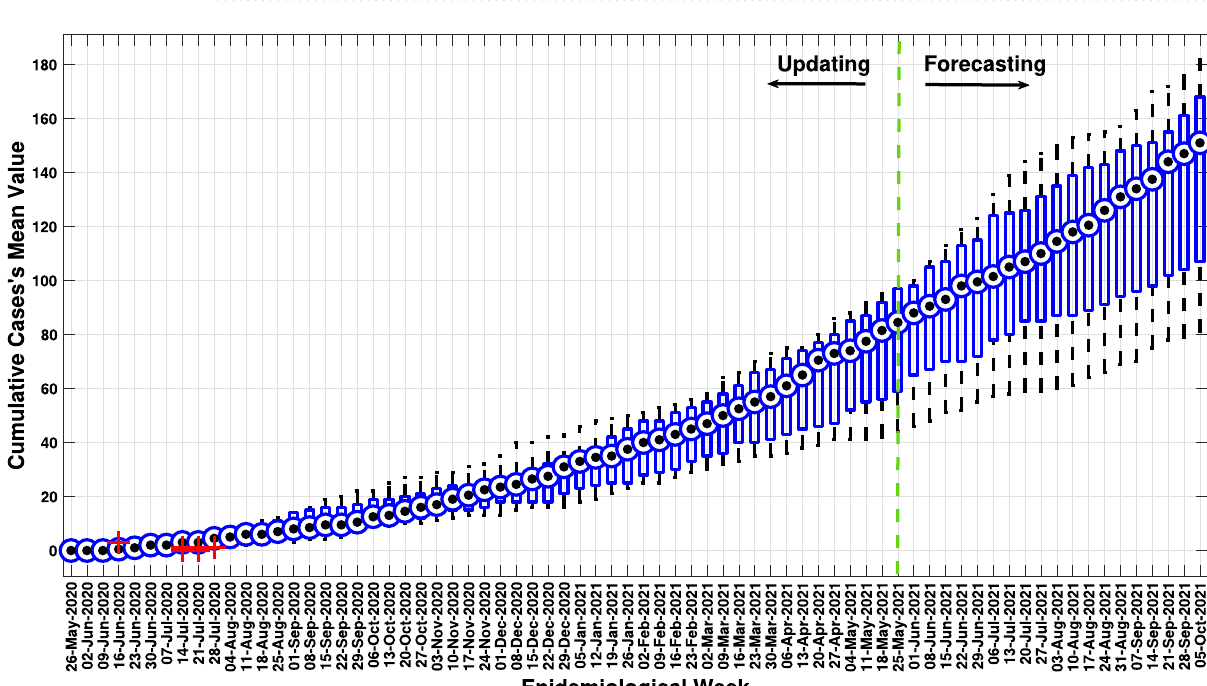
Figure 12. Boxplot analysis of updated model’s response behaviour per epidemiological